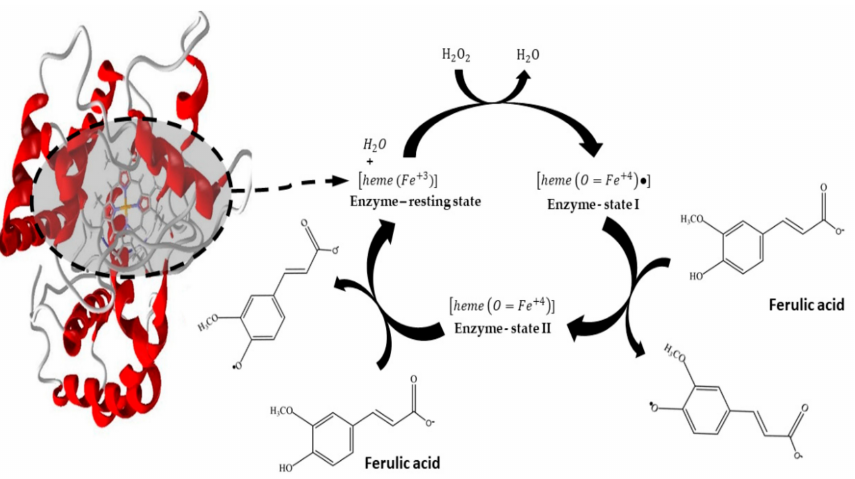
Figure 7. Peroxidases catalytic cycle involving the ferulic acid